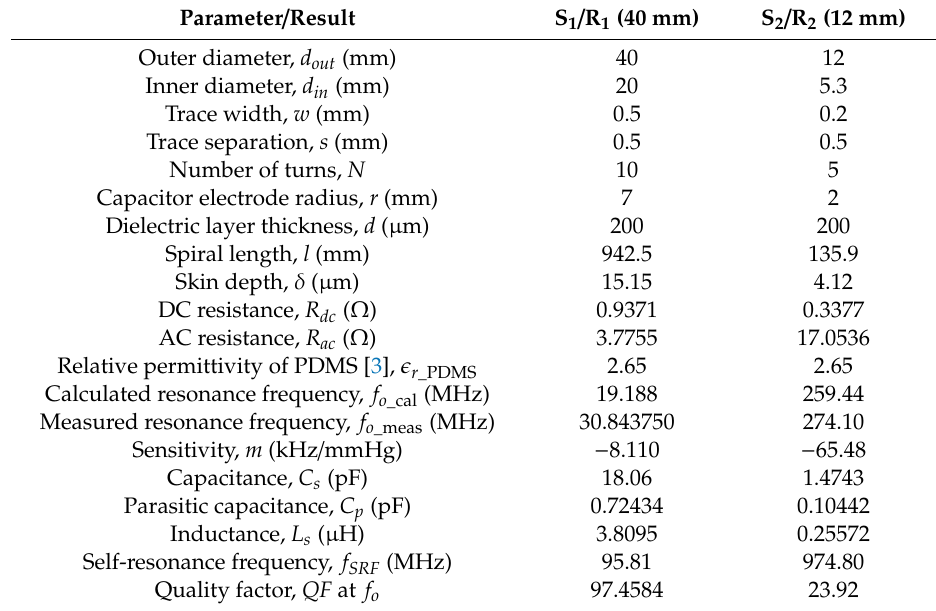
Table 1. Key design parameters and results for both sensors (S 1 , S 2 ) and their readers (R 1 , R 2 ).